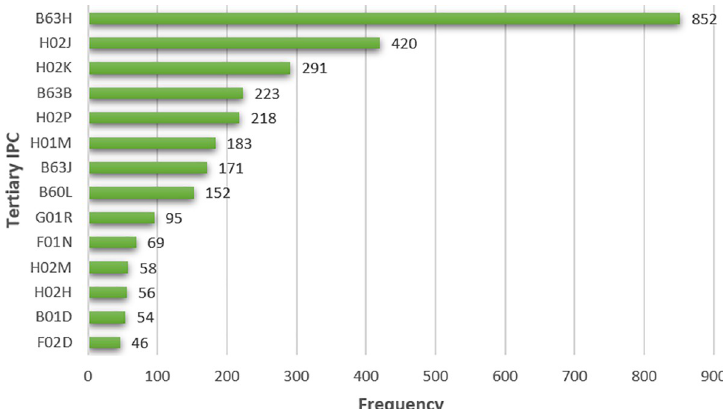
Fig 2. Third-level IPC number statistics of deweighting data